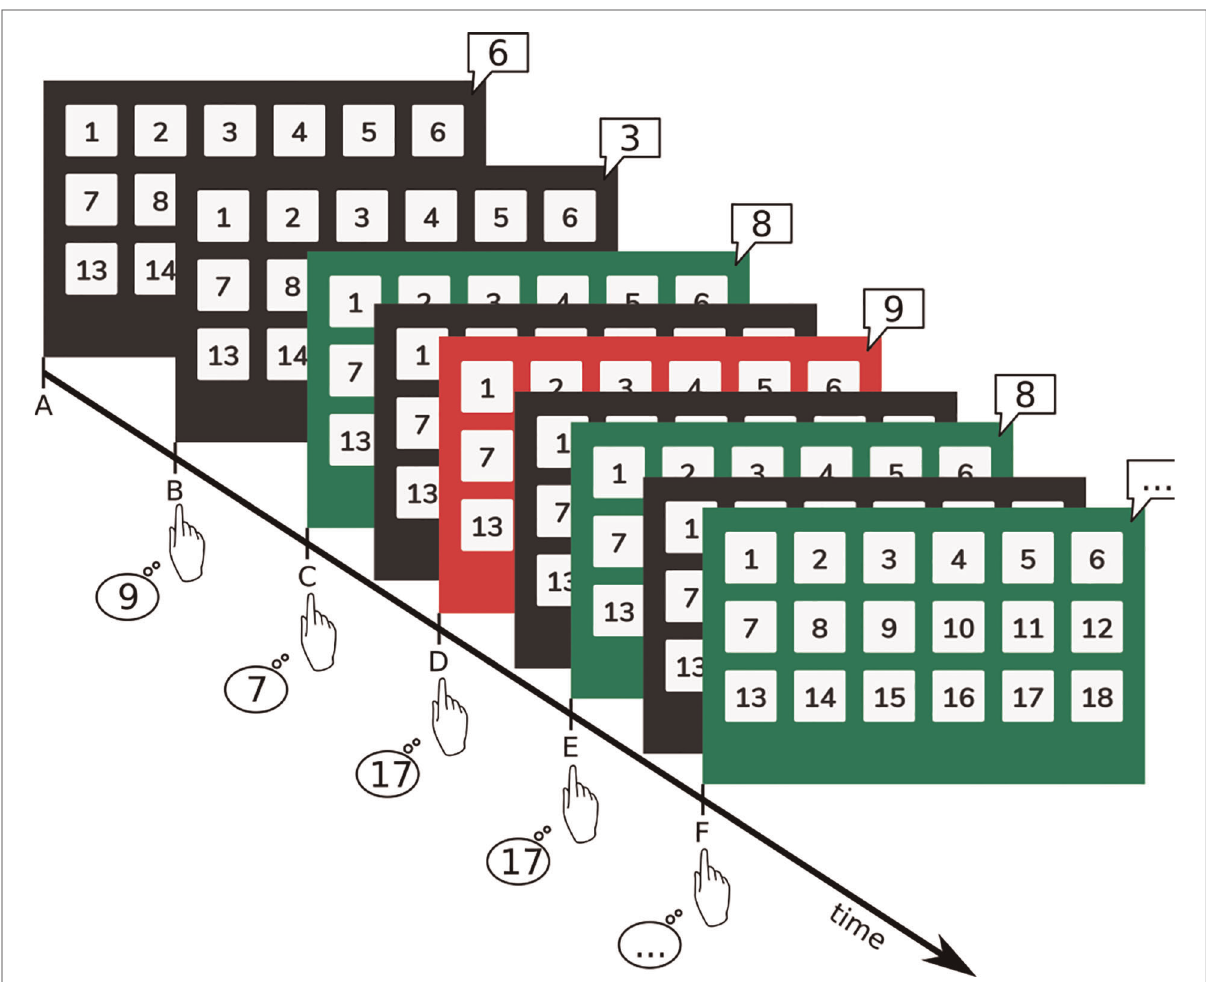
FIGURE 1 Visual representation of the PASAT. Participants heard single digit numbers (here shown in speech bubbles) from the tablet ’ s speakers and were asked to add the last digit to the second-to-last digit (e.g., digits at timepoints A+B, B+C, C+D, and so forth). Numbers were presented with an initial interval of 3 s. Answers were then given on the keyboard. For correct answers the screen brie fl y fl ashed green, for wrong answers the screen fl ashed red and then immediately return to a dark background. This feedback was given concurrently to the following digit presentation (e.g., green feedback at E refers to the correct result given for the addition of